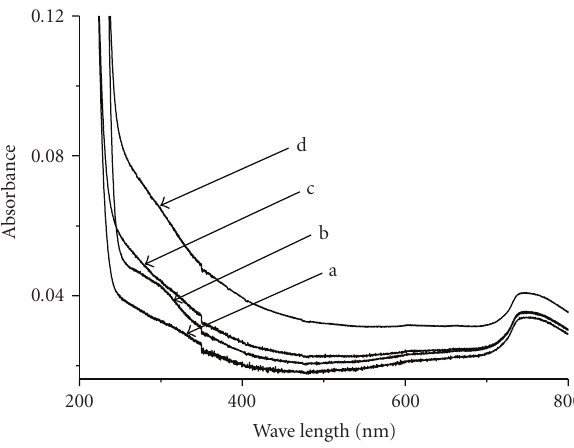
Figure 8: UV-VIS spectra of (a) 0.1 mg/L humic acid, (b) 1mg/L humic acid, (c) Warnow river sample 1: 1000 diluted, and (d) Warnow river sample 1:100